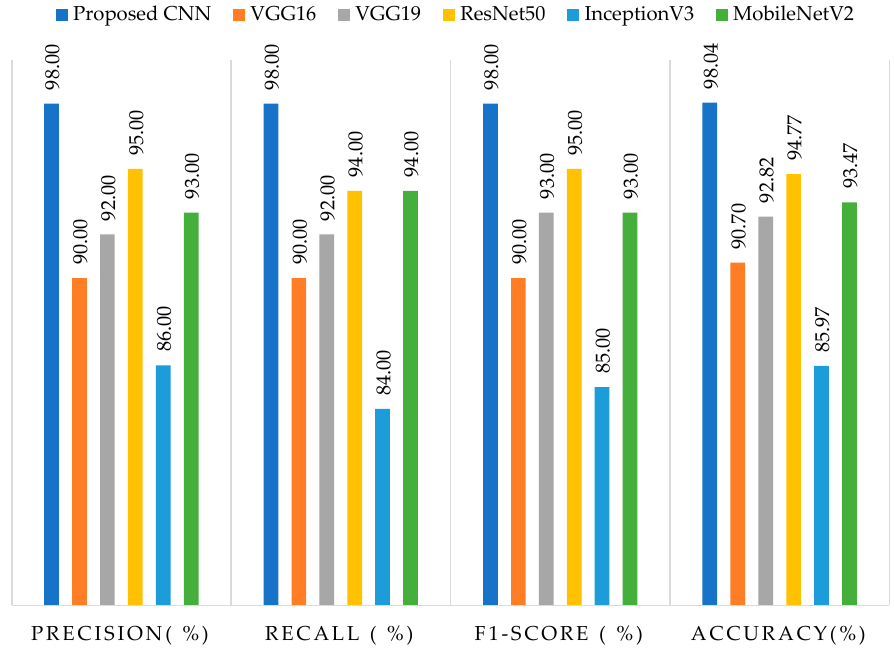
Figure 6. Represents the precision, recall, f1-score, and accuracy results on testing data with the proposed framework and pre-trained models.